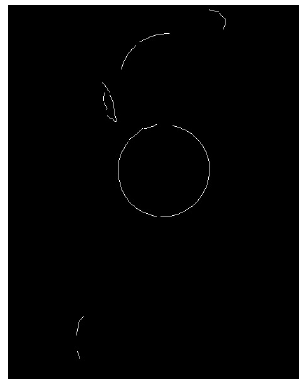
Figure 10: Circle outline detected by our